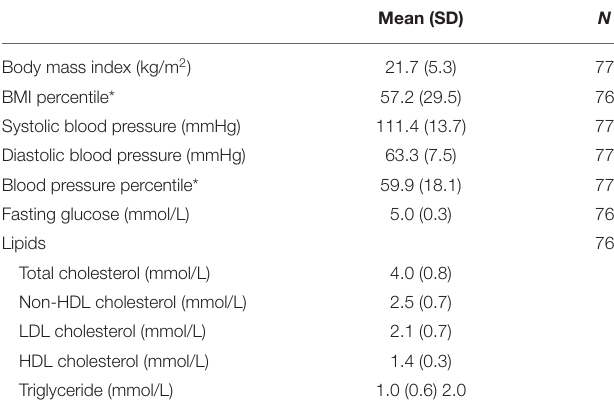
TABLE 2 | Cardiometabolic risk factors among adolescents with